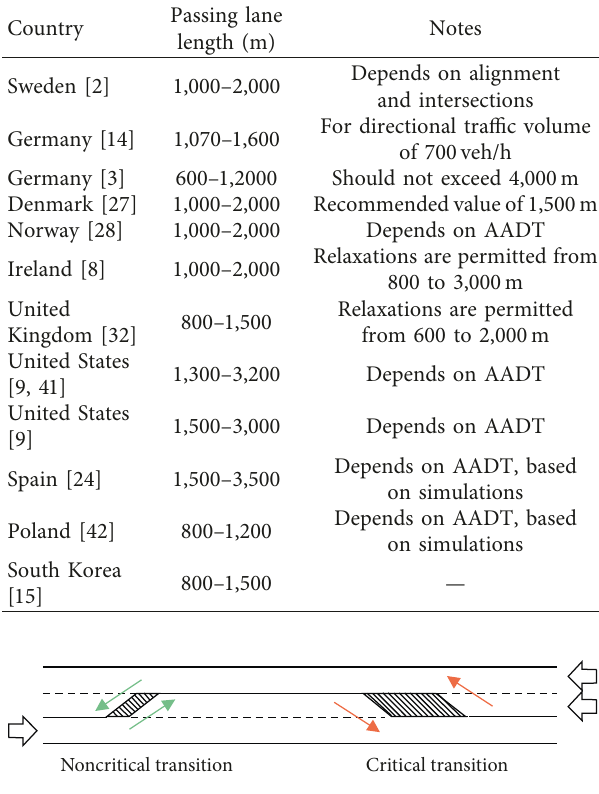
Figure 3: Critical and noncritical transitions on 2 +1